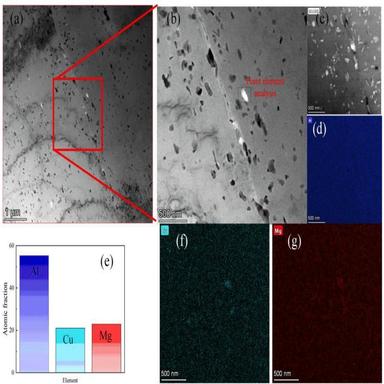
TEM Characterization of precipitates in AA2024-T3: (a) and (b) TEM bright field images showing morphology of precipitates, (c) the HAADF image of AA2024, (d), (f) and (g) the EDS mapping corresponding to the area of HAADF image and (e) the EDS point analysis results of precipitated phase.